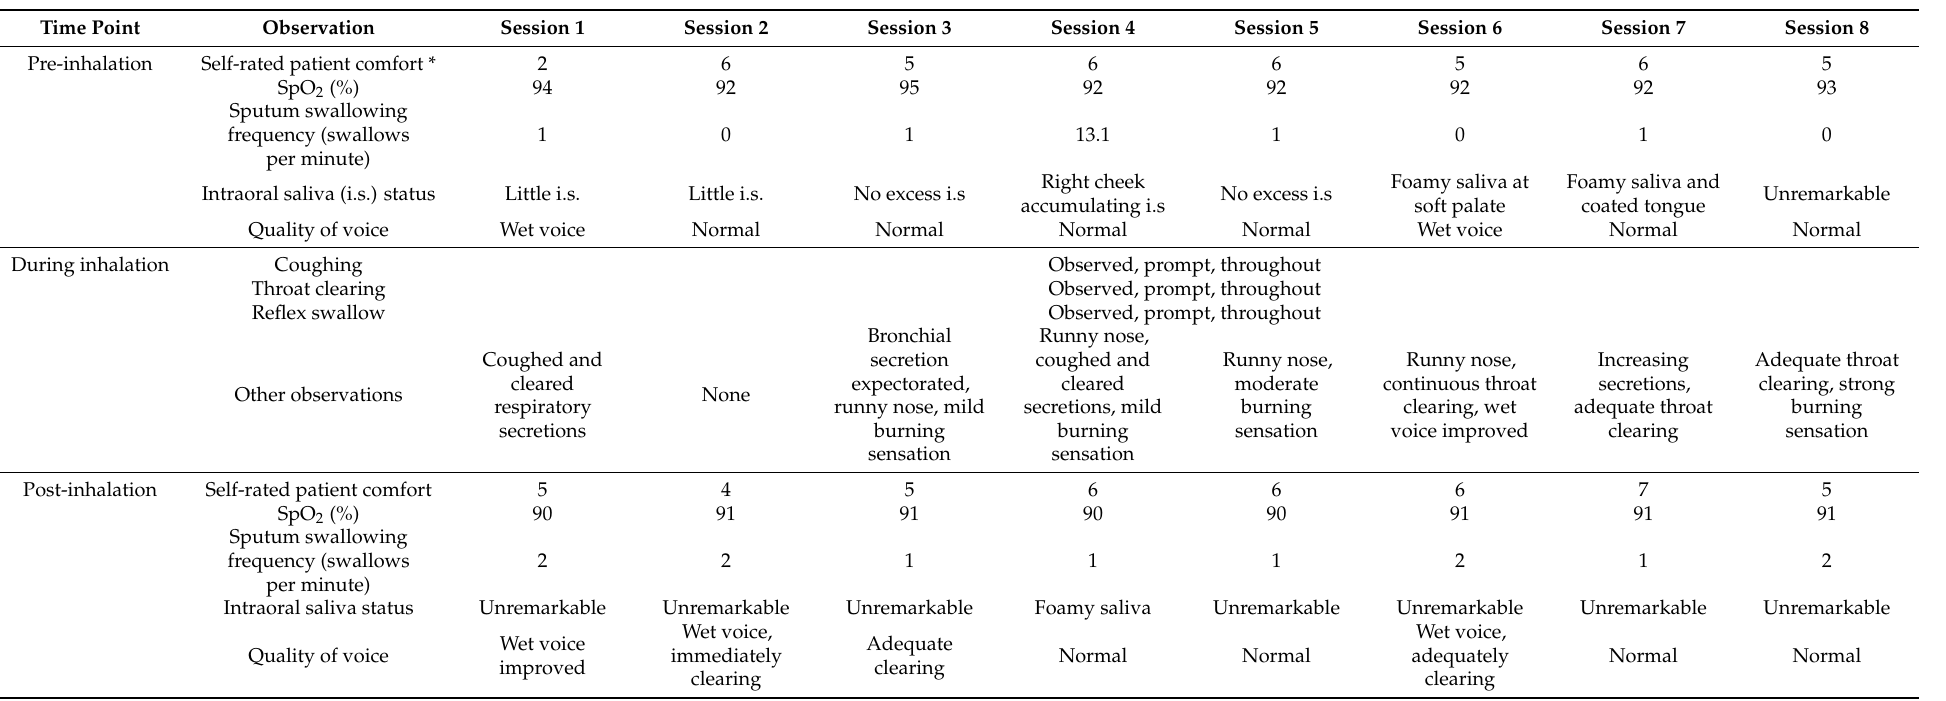
Table 2. Clinician and patient-assessed outcomes for inhalation therapy